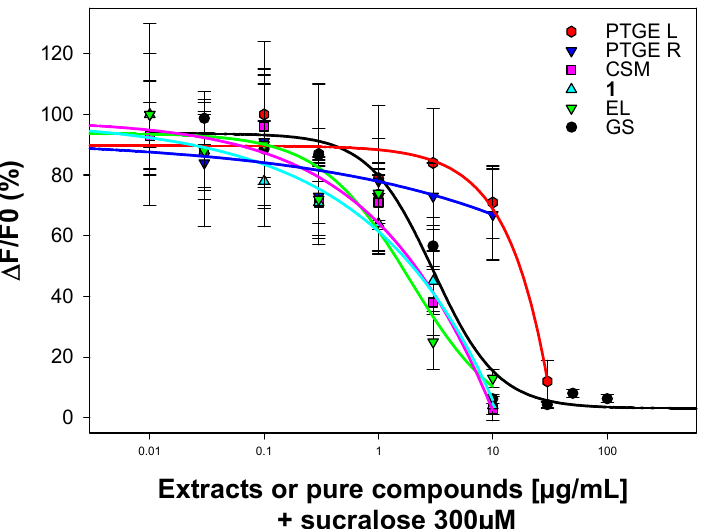
Figure 4. Sucralose responses of hTAS1R2/hTAS1R3 treated by PTGE L, PTGE R, CSM, 1 , EL, and GS.